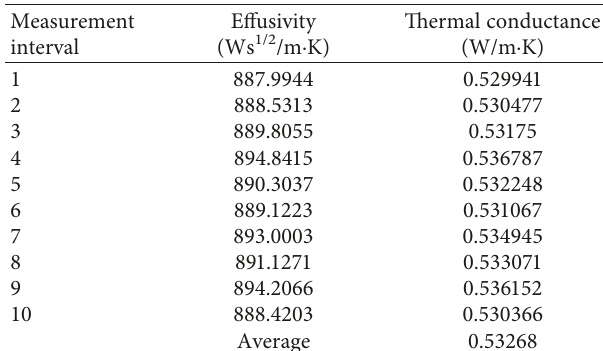
Figure 1: Scale-model cross section and temperature sensor locations. Table 1: WPC thermal conductivity measurement results including the hollow